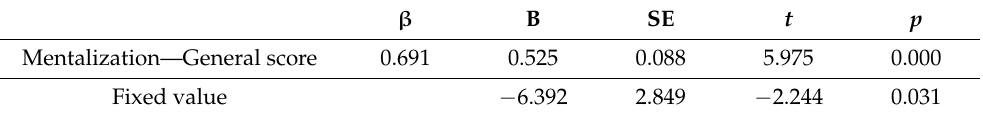
Table 10. Predictors of helplessness–hopelessness.